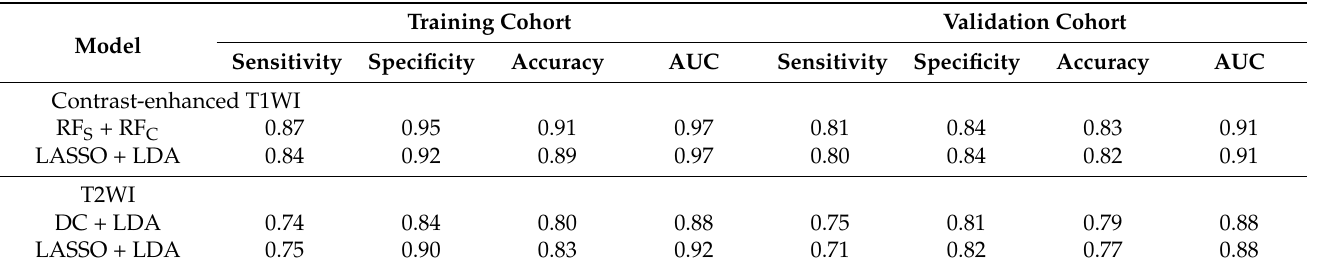
Table 3. Diagnostic value of the optimal models using parameters from the contrast-enhanced T1WI or T2WI